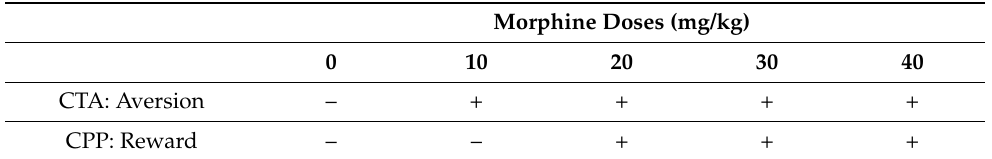
Table 1. Summary of various doses of morphine in conditioned taste aversion and conditioned place preference.